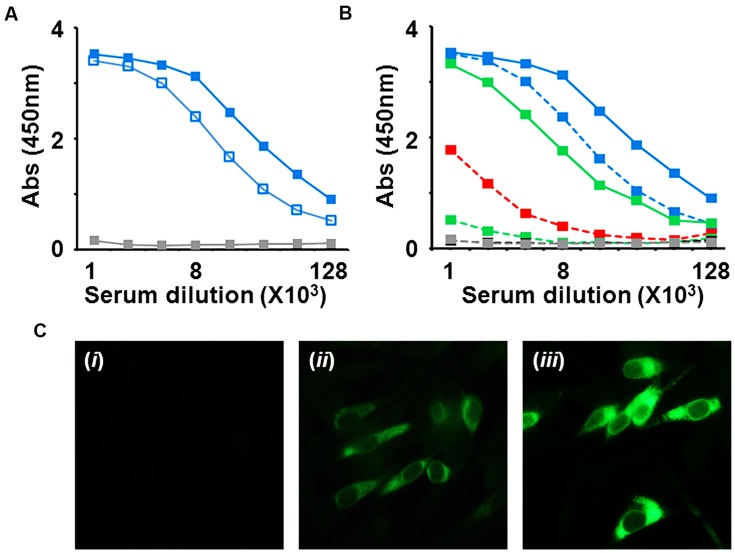
Preliminary analysis of anti-DENV-3 E VLP induced antibodies. (A) Pooled sera from DENV-3 E VLP-immunized mice after the first (open blue squares) and second (filled blue squares) boosts and mock-immunized (gray filled squares) BALB/c mice were tested in an indirect ELISA using DENV-3 E protein as the coating antigen. (B) Anti-DENV-3 E antiserum obtained after the second boost was tested in ELISAs using DENV-2 E VLPs (solid green), DENV-3 E VLPs (solid blue), recombinant monovalent EDIII-1 (dashed, red), EDIII-2 (dashed, green), EDIII-3 (dashed, blue) or EDIII-4 (dashed, black) proteins as the coating antigens. The ELISA profile of sera from mock-immunized mice (dashed, gray) is found to be superimposed over that of the immune serum against EDIII-4 as the coating antigen. (C) Indirect immunofluorescence analysis of DENV-3 virus-infected BHK-21 cells using (i) mock-immunized serum, (ii) 4G2 mAb, or (iii) anti-DENV-3 E antiserum, as the source of primary antibodies. Bound antibodies were visualized using anti-mouse IgG-FITC conjugate.